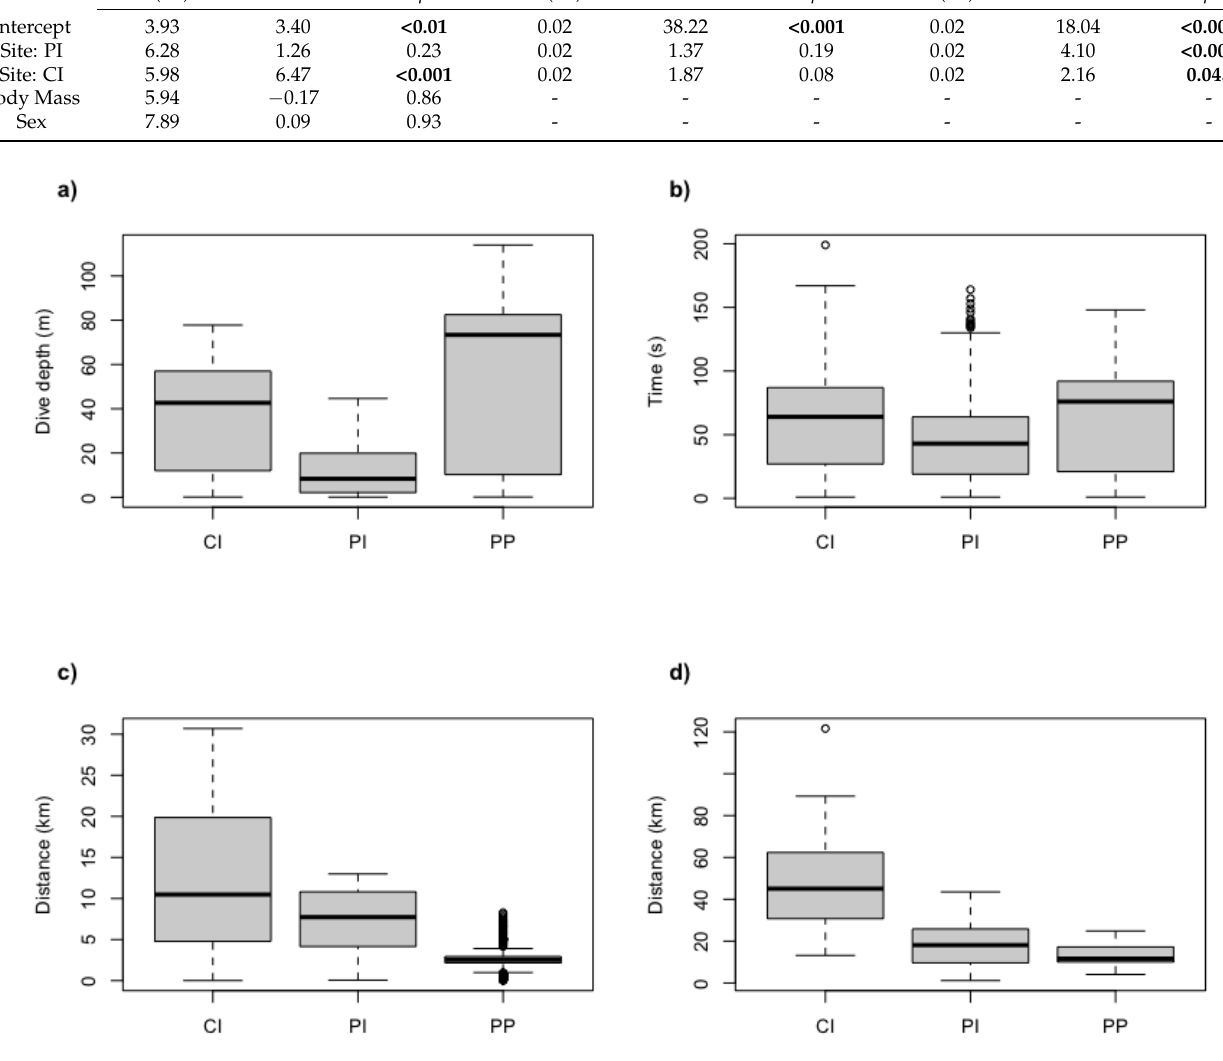
Figure 3. Boxplots of ( a ) mean dive depth depths, ( b ) bottom time (s), ( c ) foraging radii (km), and ( d ) trip lengths (km) of breeding yellow-eyed penguins from Stewart Island. CI = Codfish Island, PI = Paterson Inlet, PP = Port Pegasus. Each subfigure shows mean, 25% and 75% quartiles, and outli- ers.